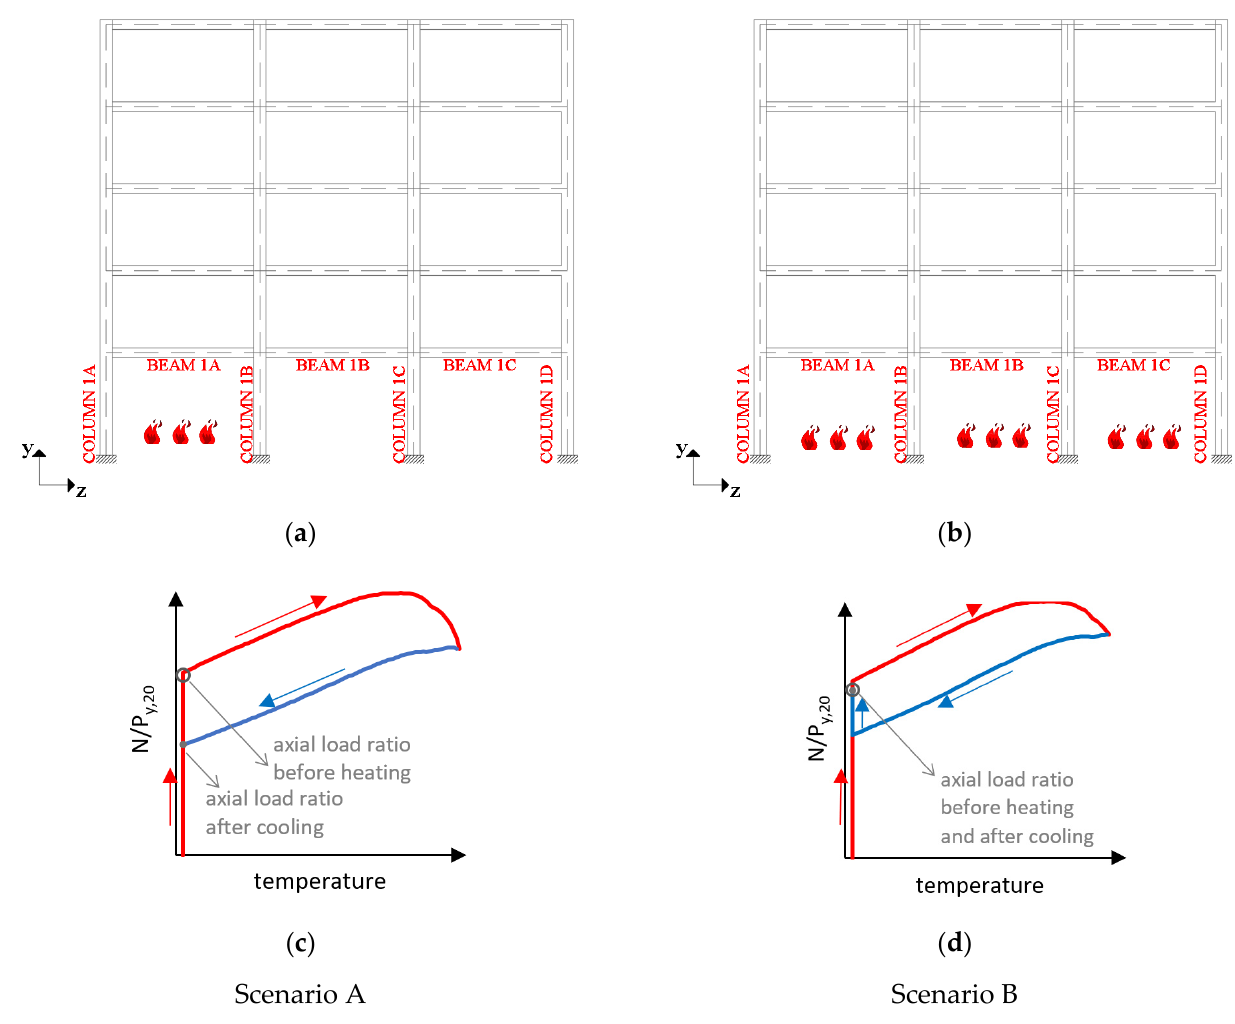
Figure 7. Fire scenarios and axial forces in Column 1B. ( a ) Fire scenario A; ( b ) Fire scenario B; ( c ) Dimensionless axial ratio for the Scenario A; ( d ) Dimensionless axial ratio for the Scenario B. The behaviour of HEA340 columns is similar to the HEB300 columns. Local web The magnitude of the maximum temperature (T max ) during the heating stage affects the deformed shape of the column at the end of the cooling stage. If the maximum tem ‐ perature (e.g., 350 °C) is less than the temperature that corresponds to the ultimate axial force (critical temperature equal to 447 °C for the HEB300_01 column), the column remains in the elastic branch and returns to its initial condition through the same path (Figure 6).